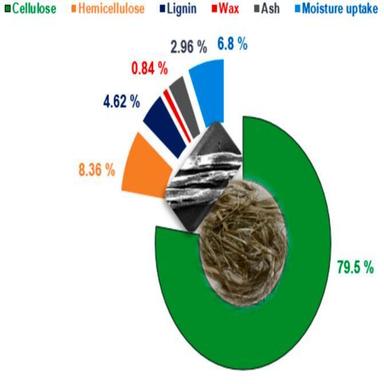
Chemical composition of HRFs.